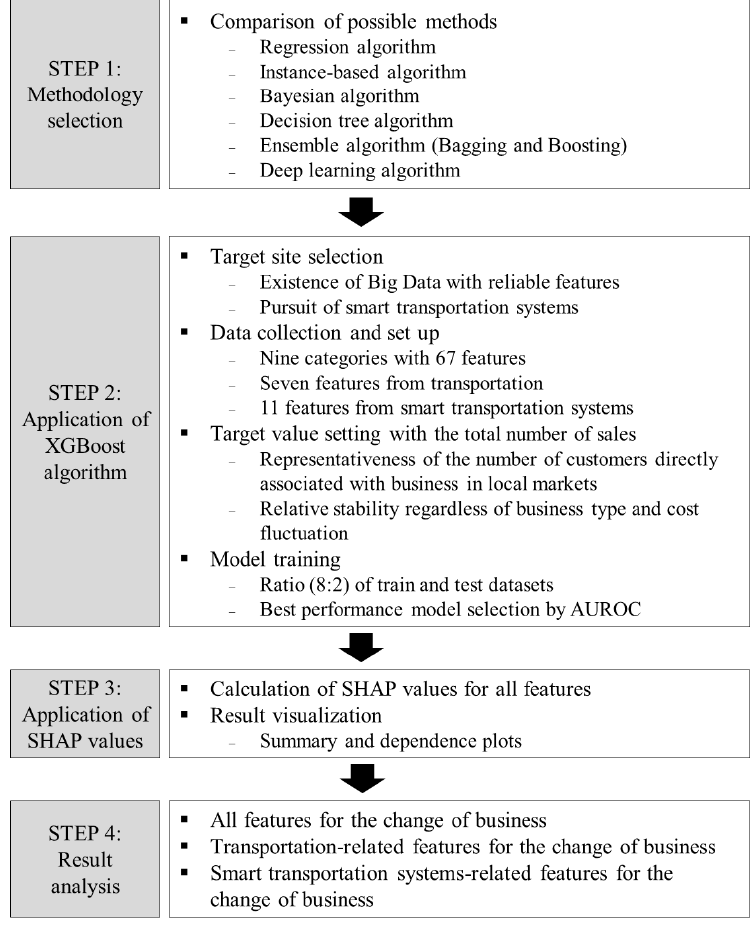
Figure 1. Overall methodological process for the analysis.